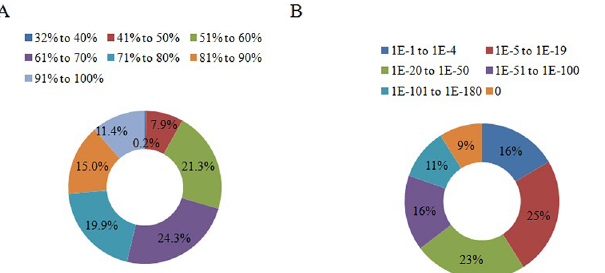
Fig 1. Homology characteristics of whitefly unitigs against the NCBI-nr database. (A) Percent similarity distribution of top blast hits. (B) E-value distribution of top blast hit unitigs.